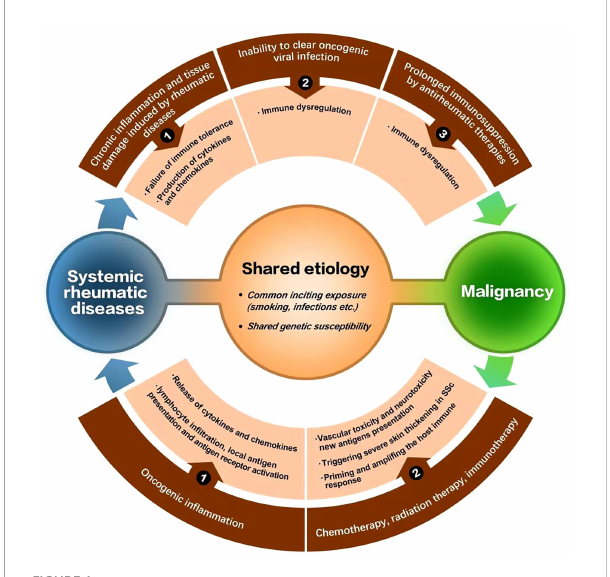
FIGURE 1 Mechanisms linking malignancies and rheumatic